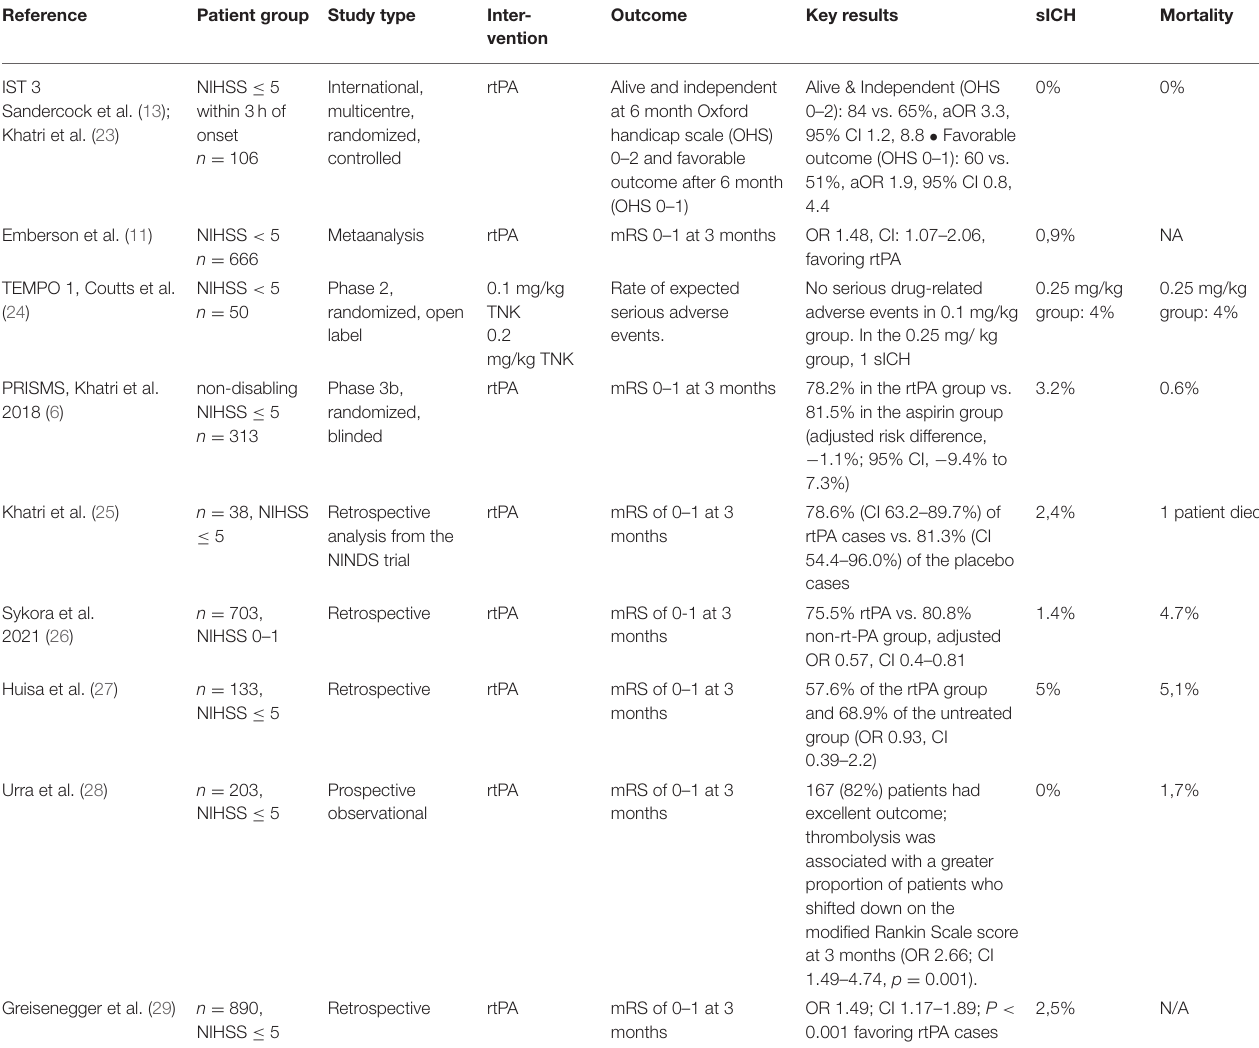
TABLE 1 | Randomized controlled trials and observational trials on thrombolysis in minor stroke. Reference Key results